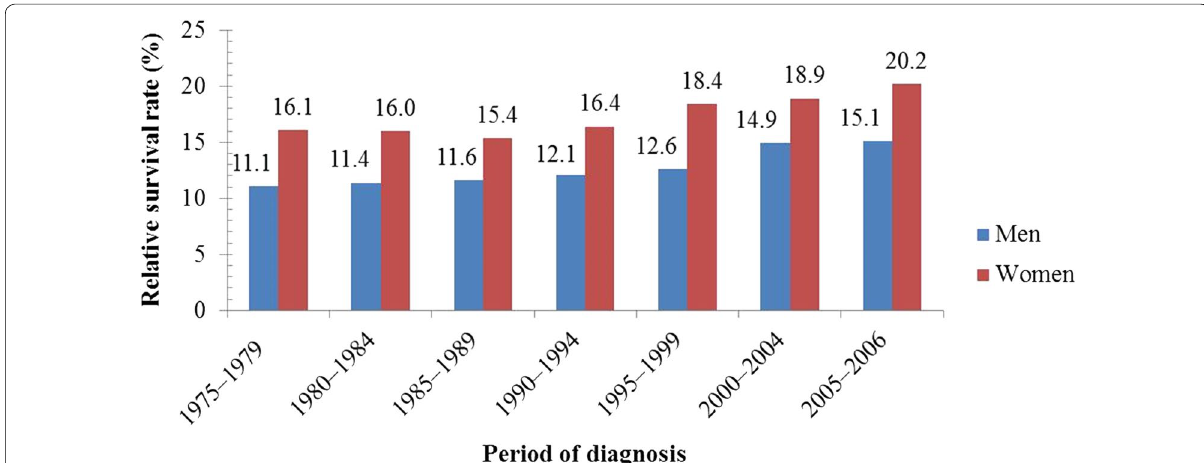
Fig. 6 Five-year relative survival trends of lung cancer patients over time in the US. The 5-year relative survival rate of men with lung cancer increased from 11.1% to 15.1%; for women, it increased from 16.1% to